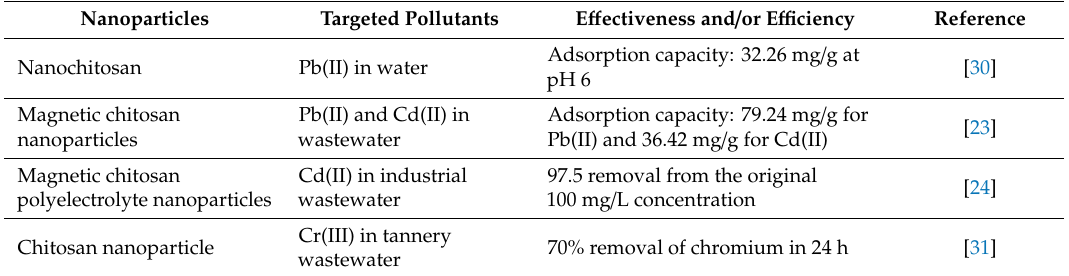
Table 1. Applications of chitosan nanoparticles in drinking water purification and agricultural / industrial wastewater